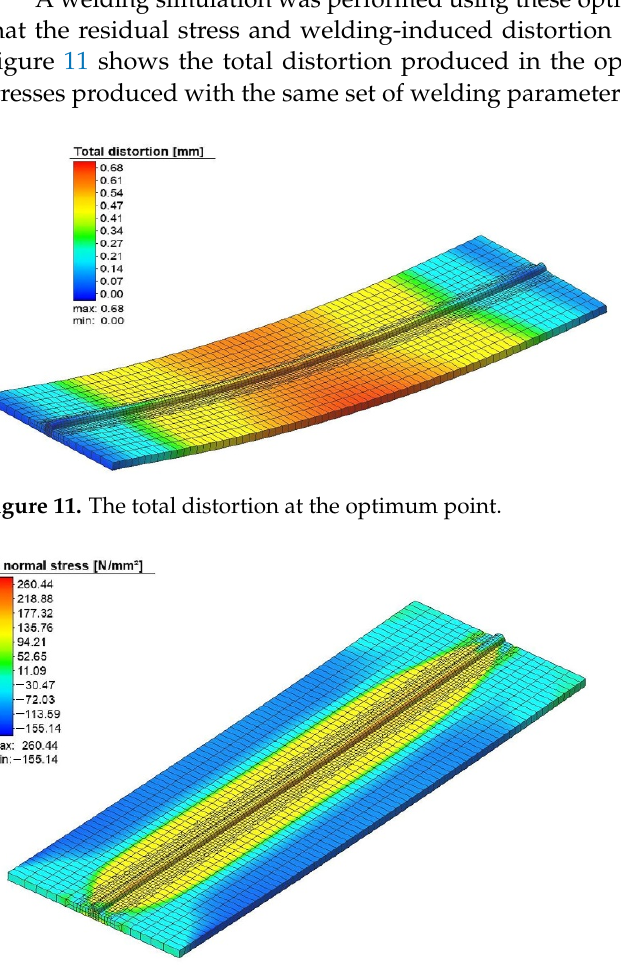
Table 4. The optimum solution .